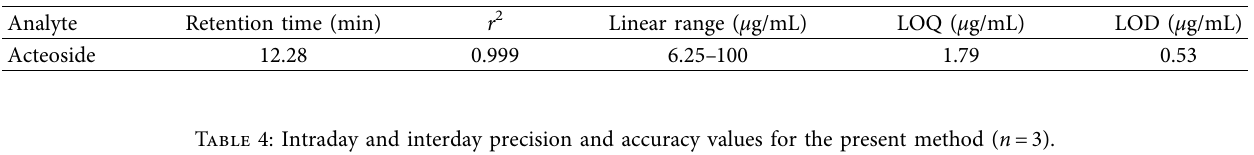
Table 3: Linearity and sensitivity of the present method.